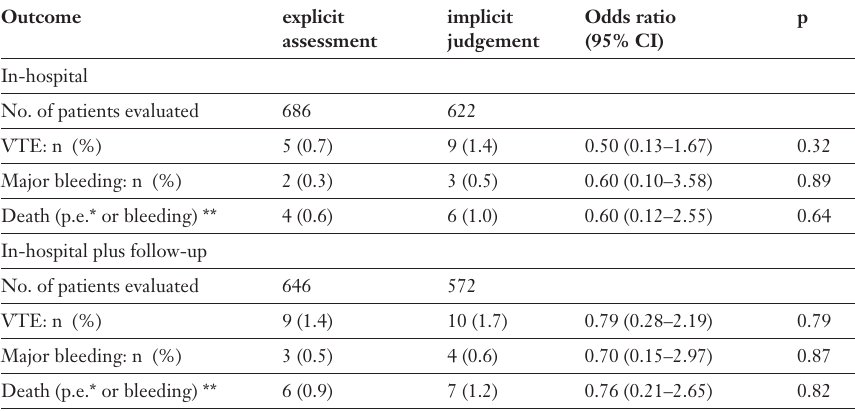
Table 2 Symptomatic venous thromboembolism (VTE) and major bleeding events during hospital stay and 90-days after